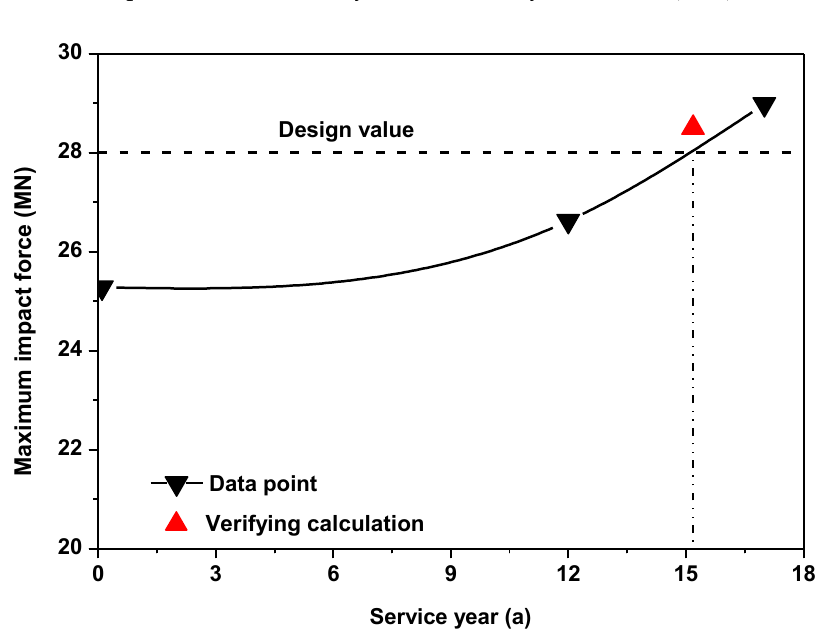
Figure 8. Prediction of maximum impact force and verification considering corrosion effect.